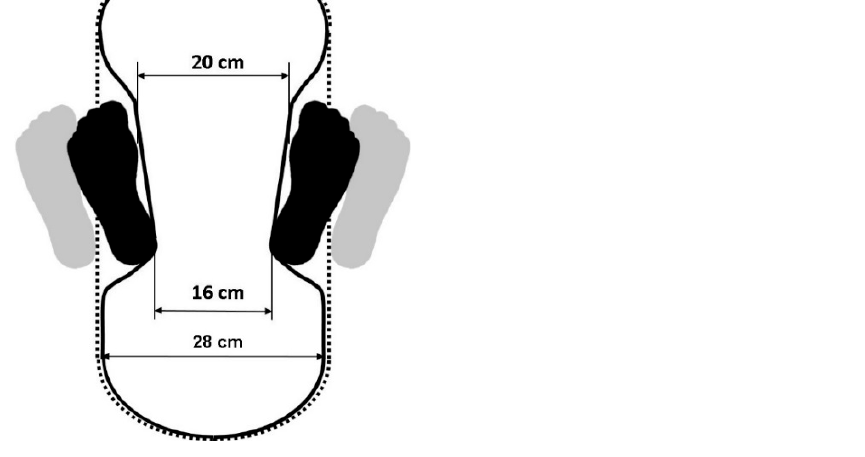
Figure 3. Remodeled squat toilet with a peanut- or dumbbell-shaped design (solid line: a new design in the study; dotted line: a typical squat toilet).